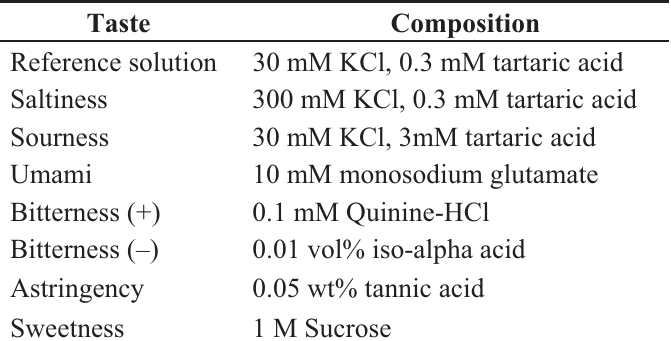
Table 1. Basic samples used in the taste